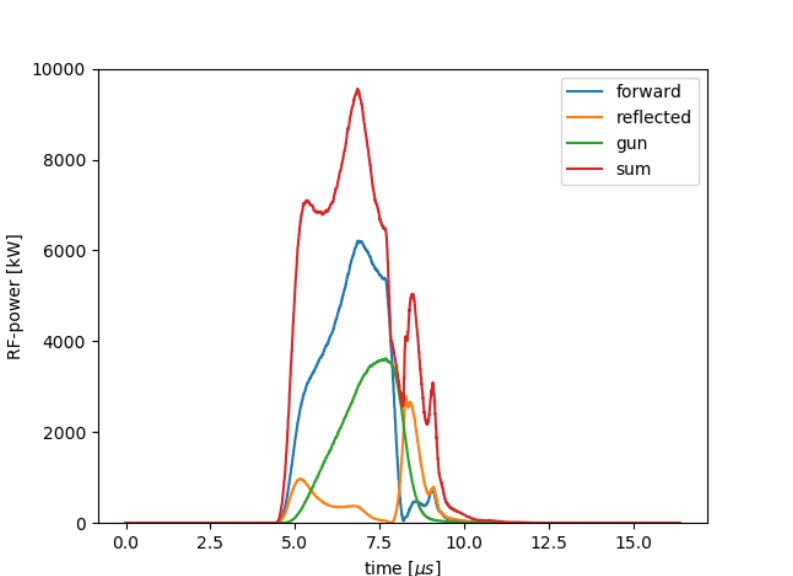
Figure 4. RF power signals in the gun cavity: Displayed are the forward (blue), probe (green) and reflected (yellow) power readout. The red curve represents the sum power given by the quadratic sum of forward and reflected